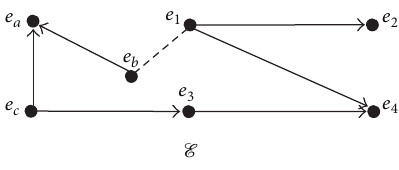
Figure 2: A Prime event structure E